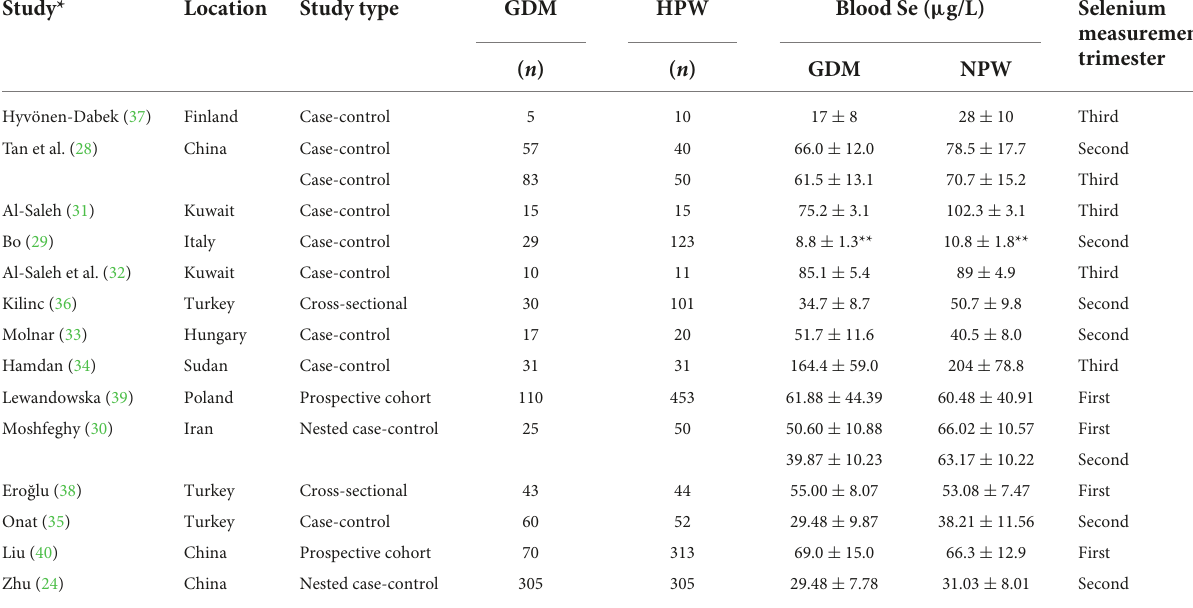
TABLE 1 Characteristics of studies included in the meta-analysis a